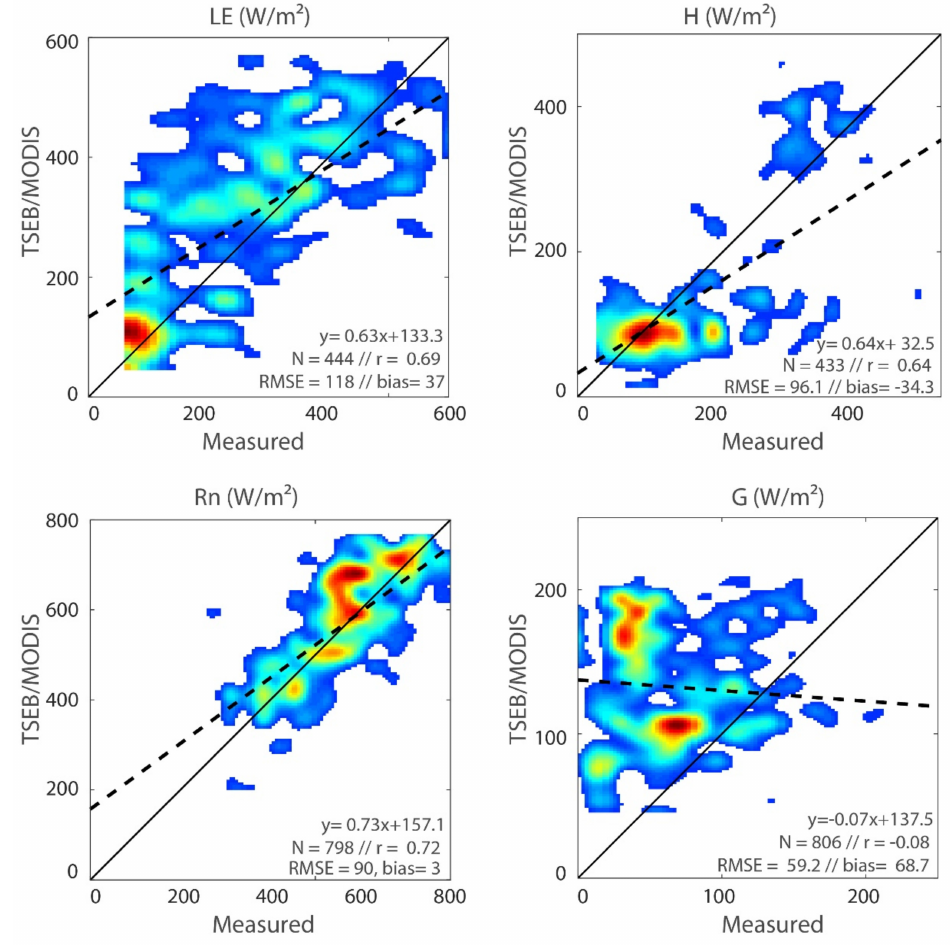
Figure 5. Benchmark of the four component of energy budget (LE, H, Rn, and G) compared to wheat site flux tower measurements. Statistical metrics RMSE and bias are expressed in W/m 2 .